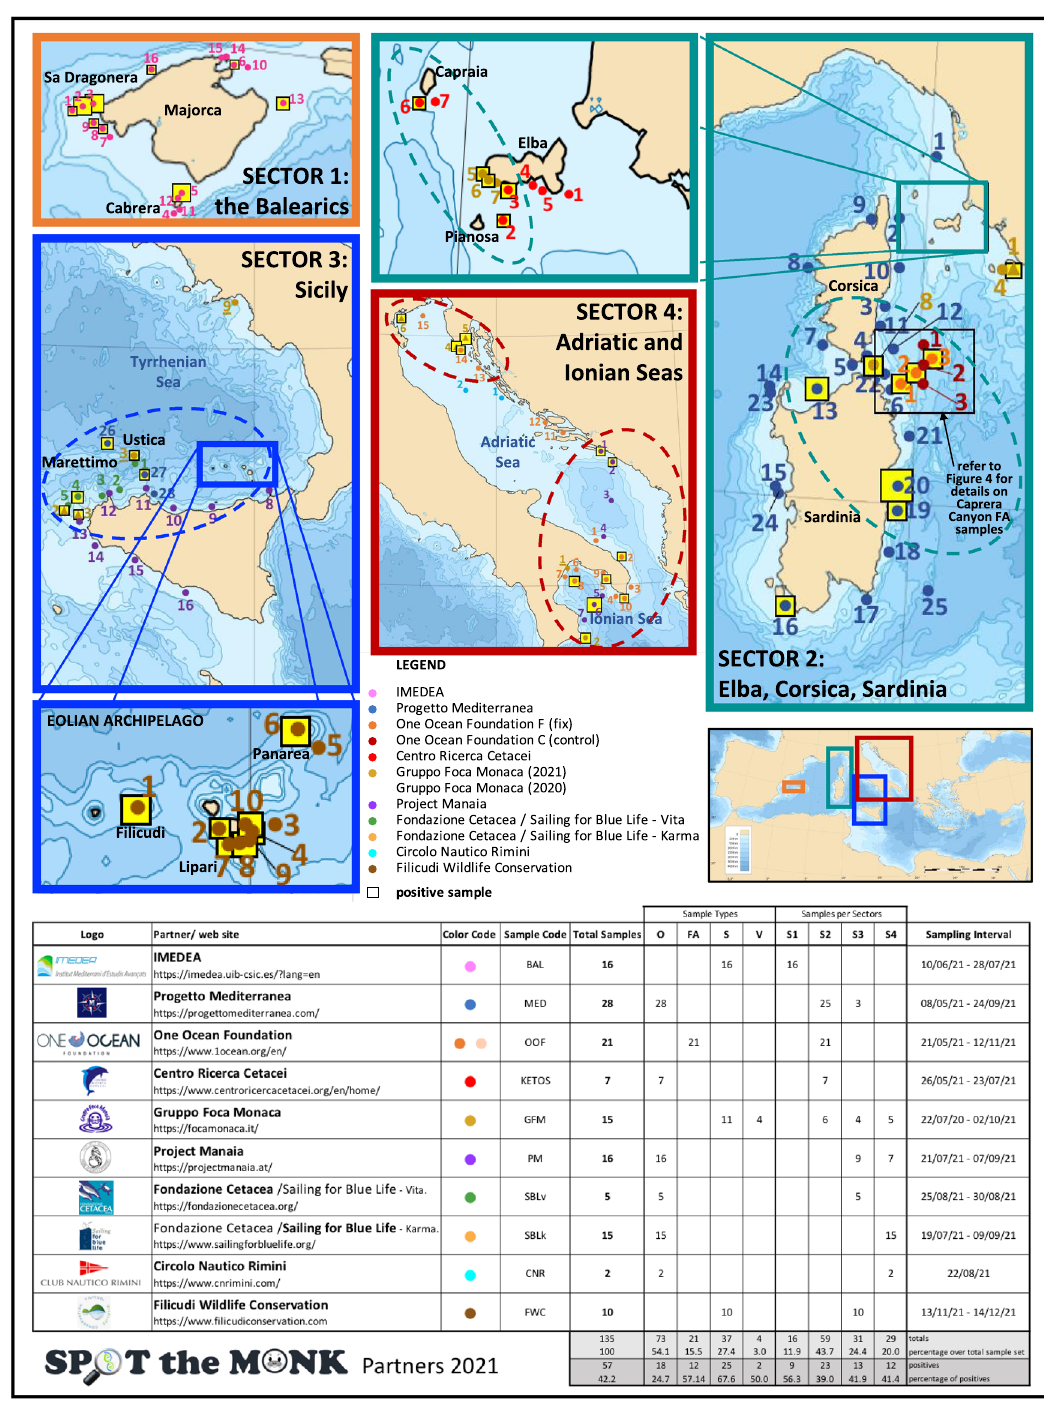
Figure 1. Maps of the four surveyed sectors showing the 120 points where samples (n = 135) were collected. Sectors’ frames are colour-coded and their geographical position in relation to the Mediterranean Sea is shown in the map at the bottom right. For Sectors 2 and 3 a sub-map (with the same colour-code as the sector) is given to illustrate the samples taken from restricted areas. Sampling points surrounded by a yellow square indicate samples that tested positive for the presence of Monk Seal DNA in at least one of the experimental replicates: the size of the yellow square is proportional to the number of positive responses (the bigger it is the stronger the signal). The dashed lines delimit areas (hotspots) where multiple positive samples were observed and which would deserve continuous monitoring. The four underscored sample-numbers indicate V samples (validation samples) collected after a reported sighting, under the GFM coordination. The bottom table lists all the Spot the Monk partners contributing to the collection of samples, and their sampling effort (detailed per sample category, sector and sampling period). The Mediterranean Sea Bathymetry map was retrieved, and subsequently cropped, from https:// commo ns. wikim edia.